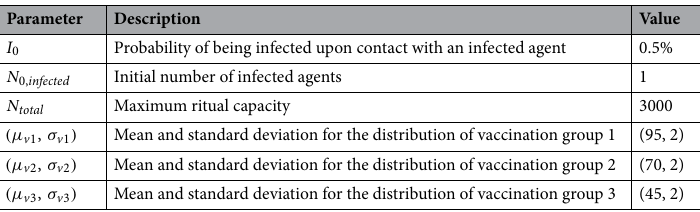
Table 1. Description and values of the simulation